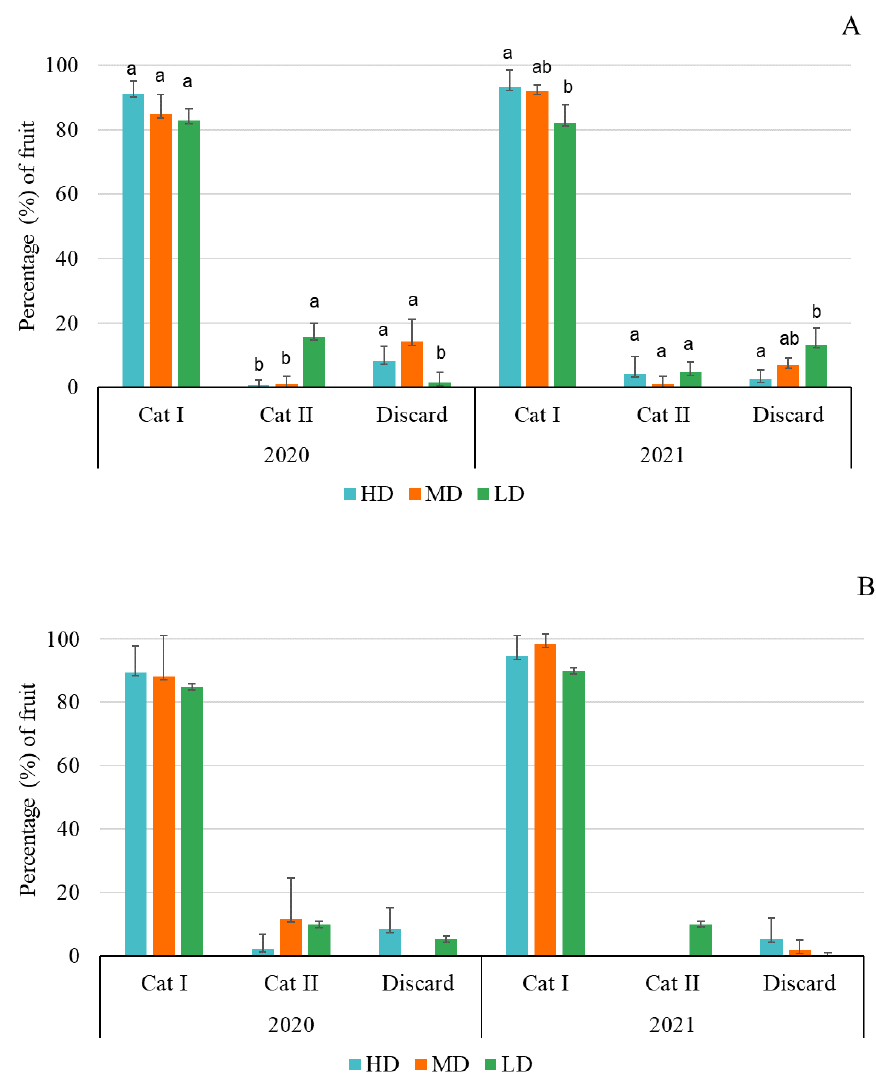
Figure 5. Percentage of triploid ( A ) and diploid ( B ) fruits according to quality categories and release density treatments (HD, MD, and LD). Different letters in each category for both cultivars indicate significant differences. (Tukey ’ s test, p < 0.05).